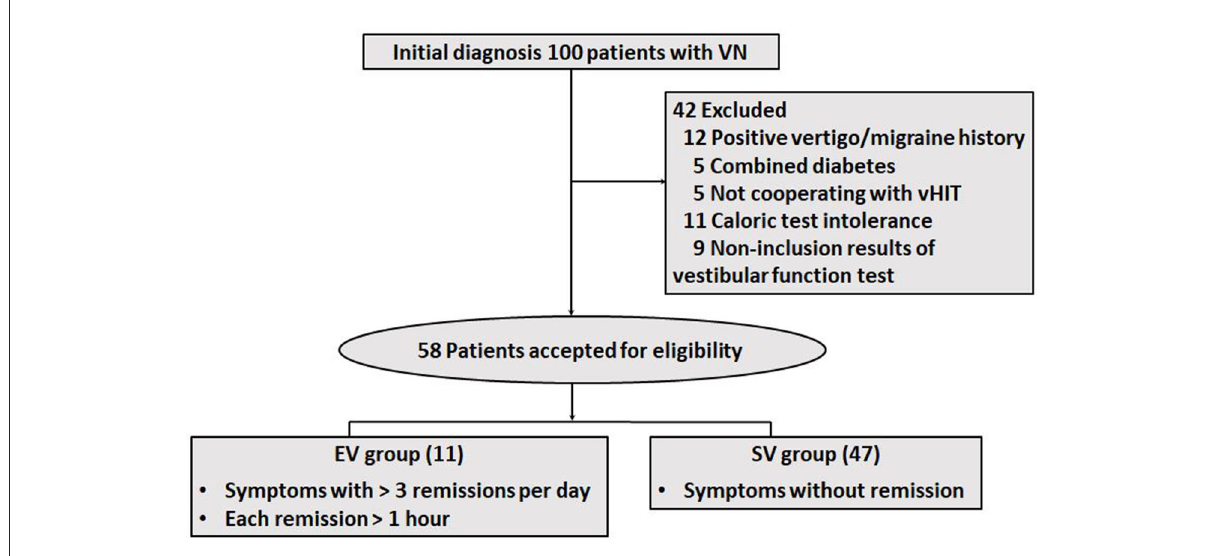
FIGURE1 Flow chart for enrolling and grouping